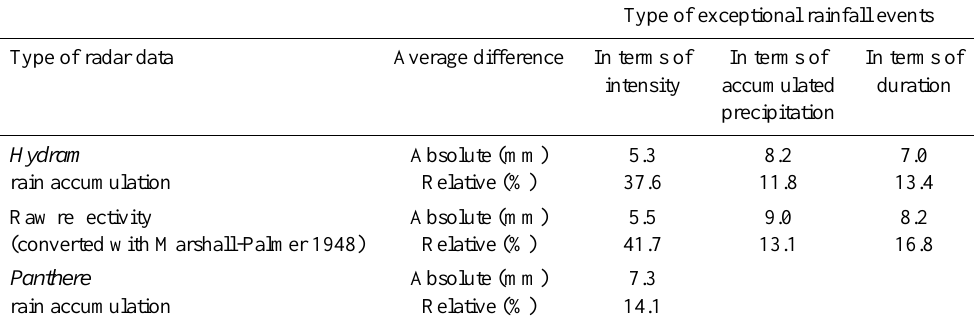
Table 1. Absolute and relative average differences between rain gauges and radar rain accumulation or radar reflectivity depending on the type of exceptional rain events (exceptional episodes in terms of intensity, accumulated precipitation or